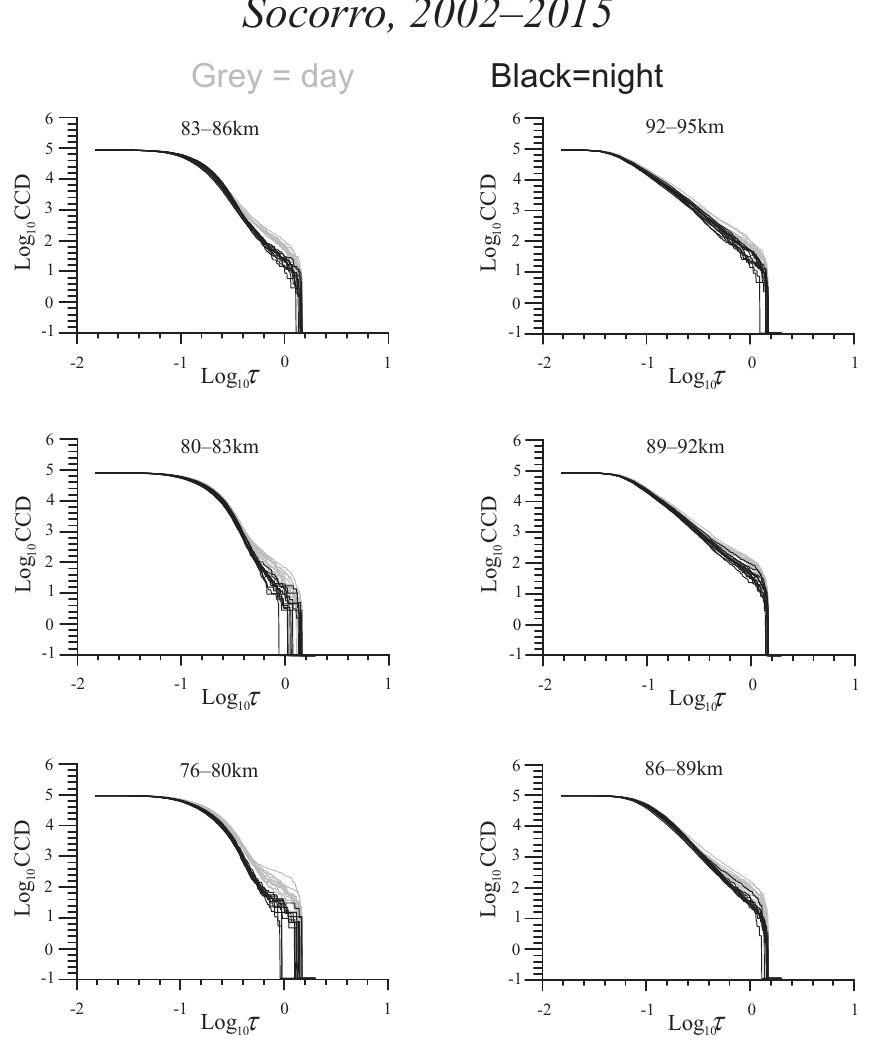
Figure 2. Complementary cumulative distributions for Socorro, New Mexico, USA, for 2002 to 2015. Each line corresponds to 1 month, with data accumulated for that month over all years. Data have been separated into day (grey) and night (black). Data are normalized as in Fig. 1. There are therefore 12 separate grey lines (one for each month) and 12 separate black lines (also one for each month) in each height bin. It is clear that, in general, the normalized counts for night-time are suppressed relative to daytime to the right of log 10 τ =− 0.4 for all heights, with the suppression being greatest at the lower heights and the largest decay